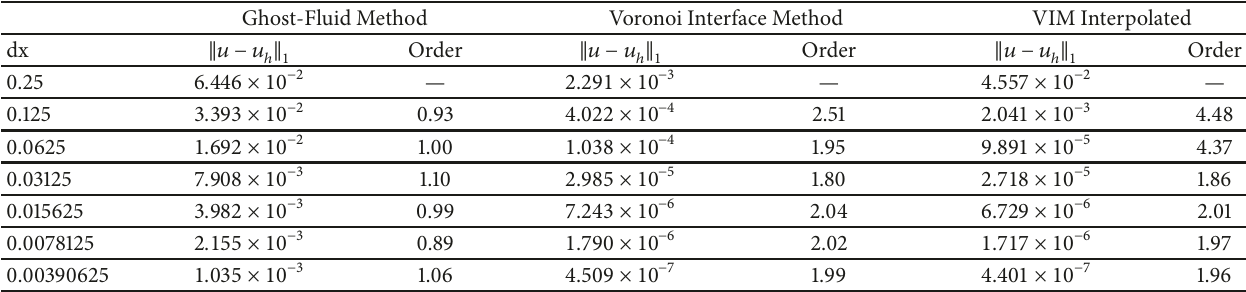
Figure 2: Visualization of the exact solution 𝑢 (left) and of the diffusion coefficient 𝛽 (right), for example, shown in Section 3.2. Table 6: Comparison of the 𝐿 1 error in the solution for the Ghost-Fluid Method and the Voronoi Interface Method, for example, shown in Section 3.2.